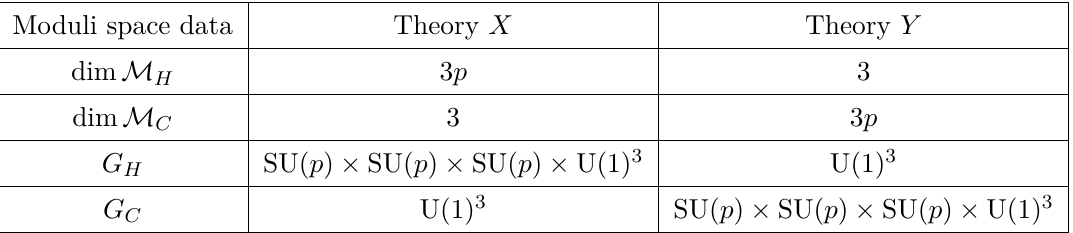
Table 13 . Summary table for the moduli space dimensions and global symmetries for the mirror pair in figure 37.